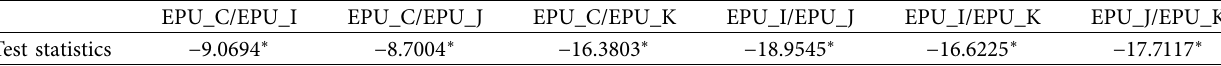
Table 5: Engle-Granger cointegration results.